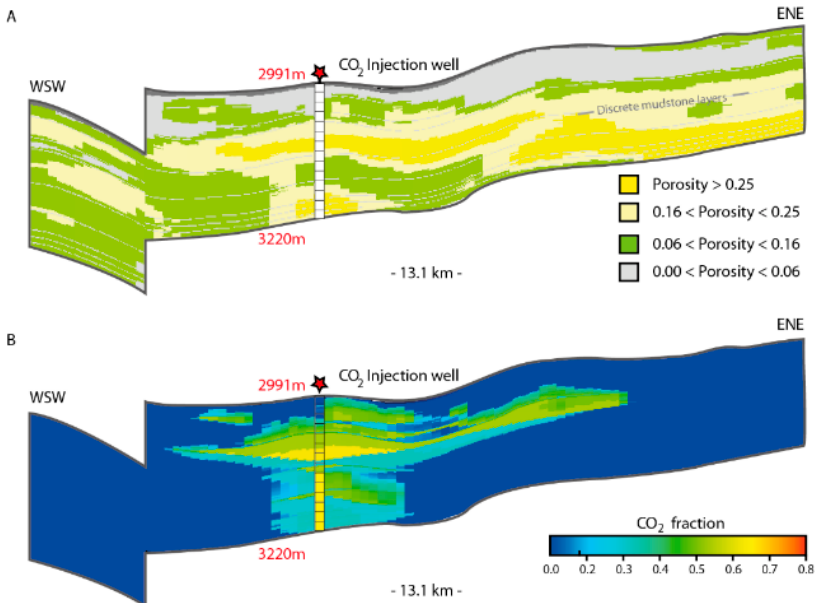
Figure 12. Fluid distribution relative to sedimentary facies with different mineralization potentials: ( A ) Interpreted facies distribution related to porosity class and interpreted from seismic attribute analysis (acoustic impedance). Upper shoreface (high porosity and permeability) in dark yellow, lower shoreface (intermediate porosity and permeability) in light yellow. Non-reservoir siltstones and mudstones in green and grey. Model described in [28]; ( B ) fluid distribution at 100 years, after 50 years of injection 3 Mt / y CO 2 through a well perforated in the lower half of the reservoir. In this case 16% of CO 2 was dissolved, 38% residually trapped [28].